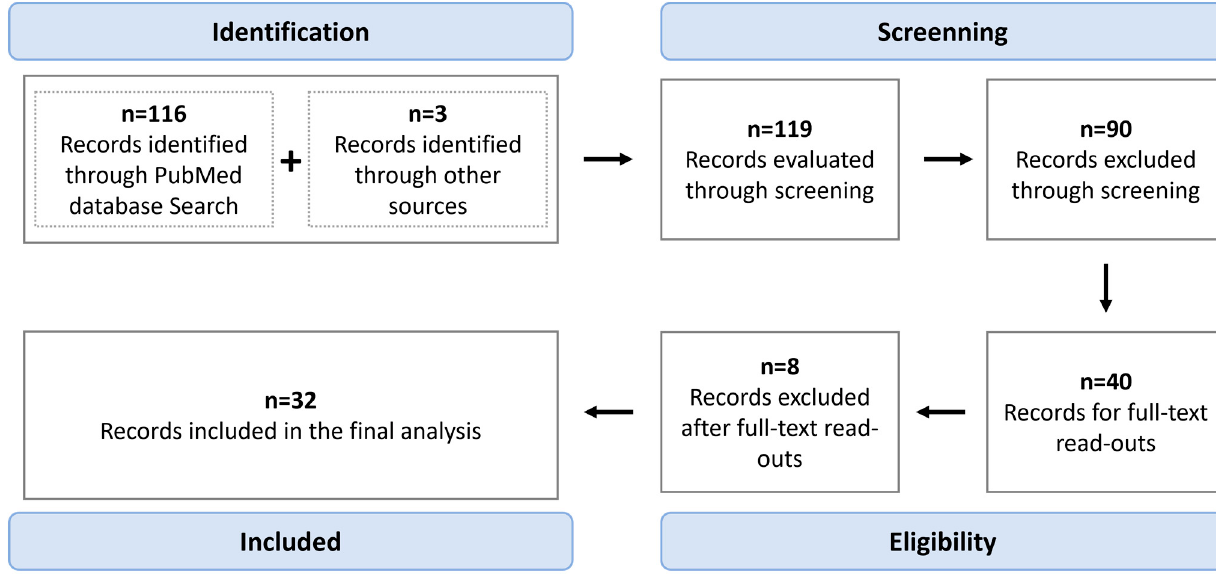
Figure 1. Flow diagram summarizing the methodology used in this review.